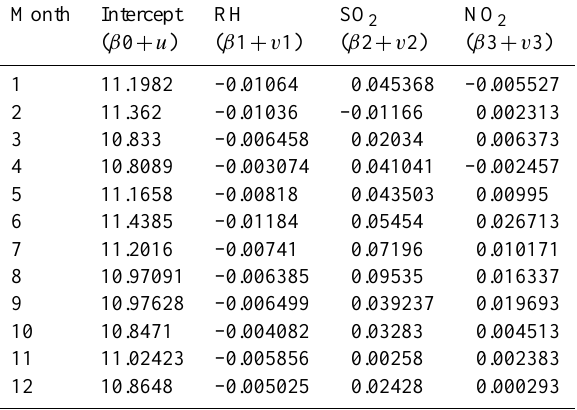
Table A4. Coefficients not used in